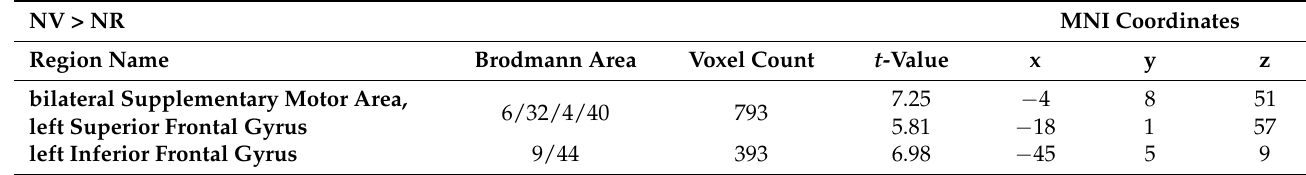
Figure 3. Activation maps for ( a ) NA > NR, ( b ) NV > NR and ( c ) NA > NV. Color bars represent t values. The threshold values of the activation maps were p < 0.001 at the voxel level and p < 0.05 at the cluster level with family-wise error (FWE) correction. Table 1. Activation peaks and extents for NA > NR.